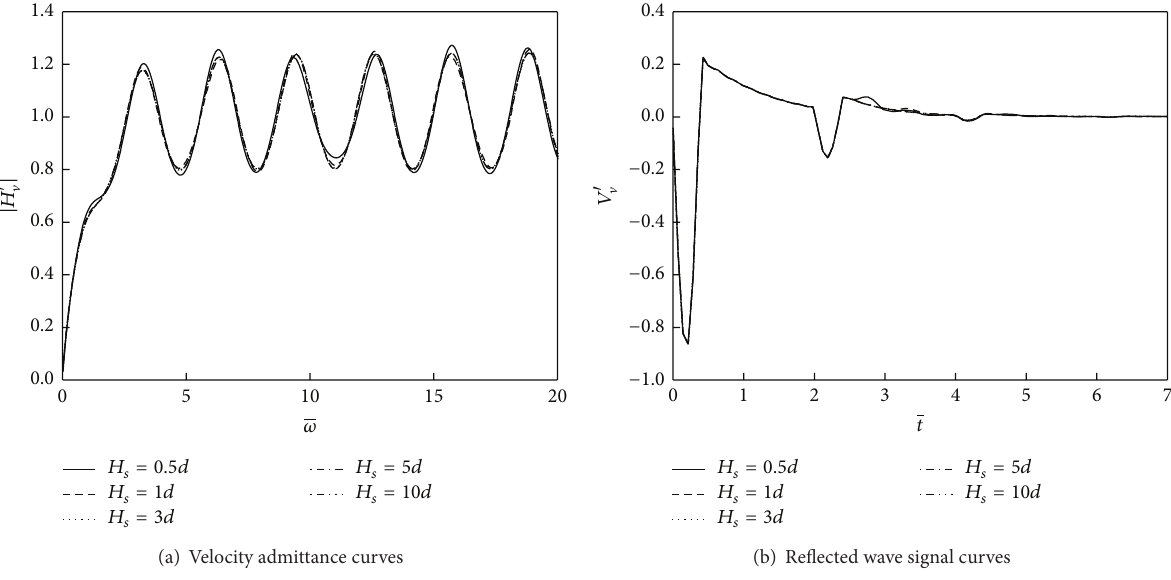
Figure 5: Influence of thickness of pile end soil on the dynamic response at pile head when 𝑟 0 = 0.5